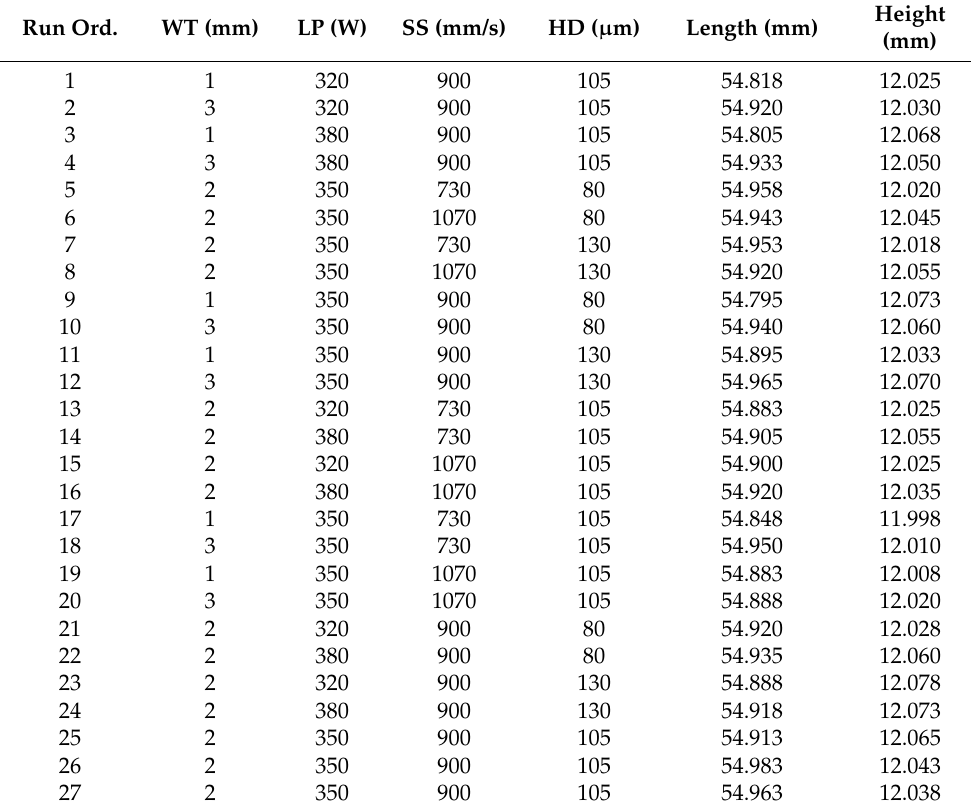
Table 6. Average values of the length and height of the samples. Run